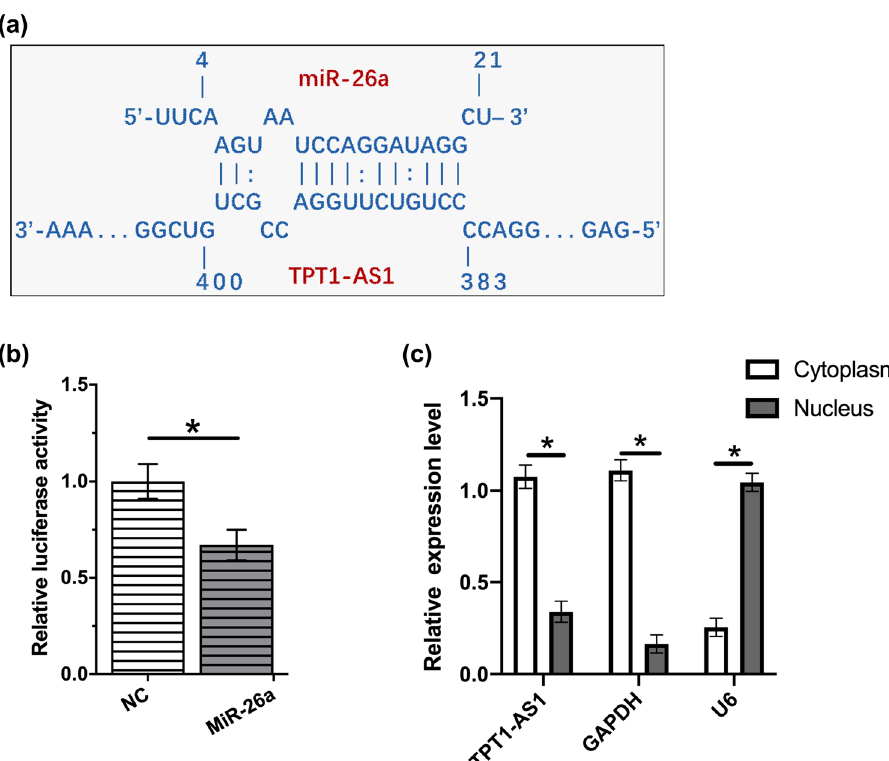
Figure 1: TPT1 - AS1 interacted with miR - 26a. ( a ) TPT1 - AS1 was predicted to interact with miR - 26a. ( b ) KYSE510 cells were transfected with pGL3 - TPT1 - AS1 - promoter + pRL - TK + NC miRNA or pGL3 - TPT1 - AS1 - promoter + pRL - TK + miR - 26a mimic. Luciferase activity was assessed by using the corresponding assay kit. ( c ) TPT1 - AS1 level in the nucleus and cytoplasm of ESCC cells. *, p <